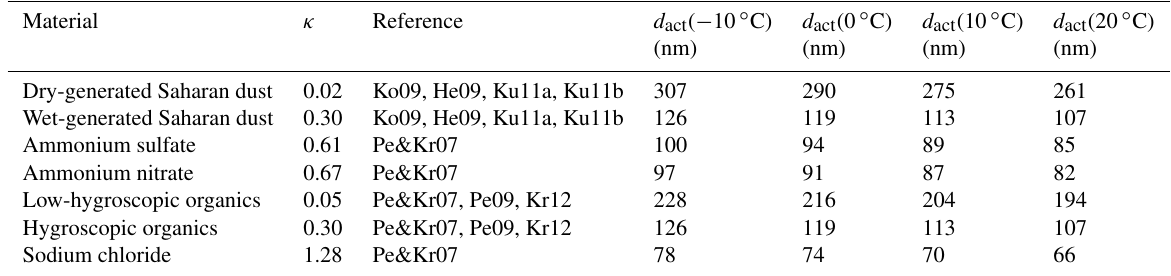
Table 3. Dry activation diameter d act for various chemical compositions calculated with kappa-Köhler theory (Petters and Kreidenweis, 2007). The κ values are estimated from literature (Ko09 – Koehler et al., 2009; He09 – Herich et al., 2009; Ku11a – Kumar et al., 2011a; Ku11b – Kumar et al., 2011b; Pe&Kr07 – Petters and Kreidenweis, 2007; Pe09 – Petters et al., 2009; Kr12 – Kristensen et al., 2012). The uncertainty in κ can be considerable especially for Saharan dust and